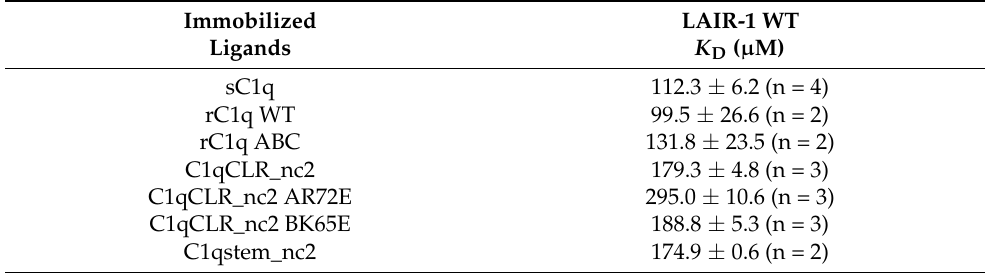
Table 1. Equilibrium dissociation constants for the binding of LAIR-1 WT to C1q and C1q